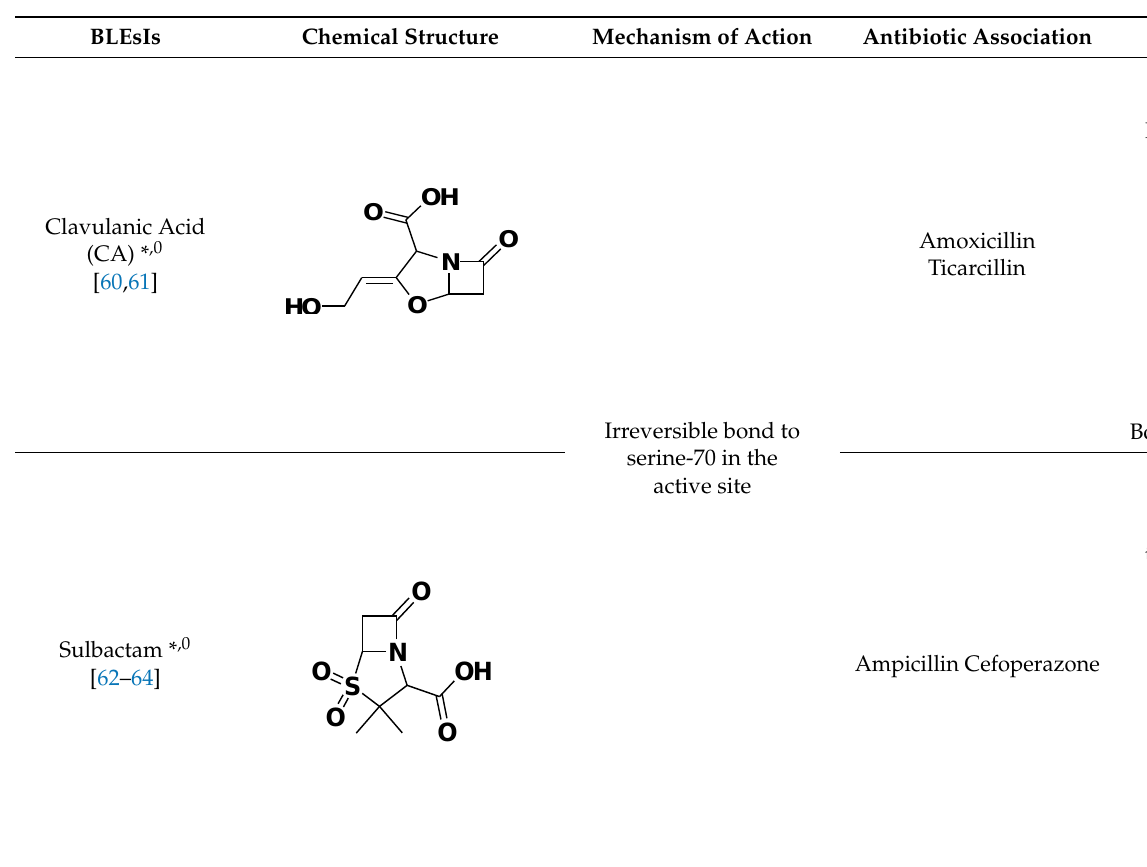
Table 3. Long-standing, recently approved, and not yet approved BLEsIs. The chemical structures were drawn using the ChemDraw Ultra 7.0 software (Chem Office 2002).